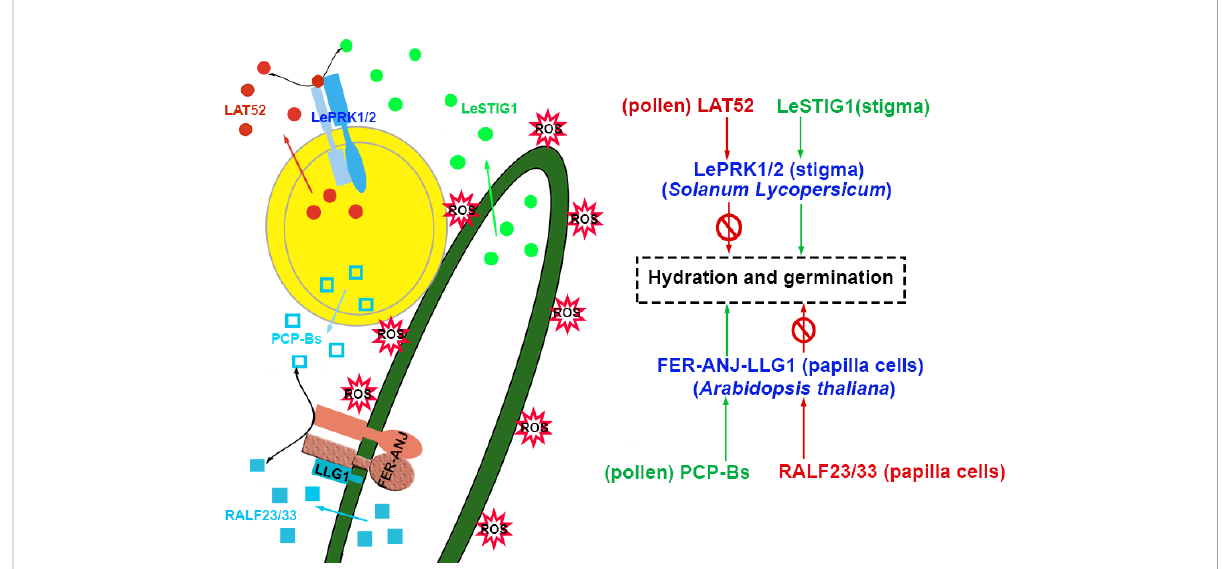
FIGURE 2 Pollen and stigma recognize each other to initiate the hydration and germination of pollen. In Solanum Lycopersicum , LAT52 interacts with LePRK1/2 to inhibit hydration and germination, and LeSTIG1 interacts with LePRK1/2 to facilitate hydration and germination. However, in Arabidopsis , pollen-speci fi c PCP-Bs bind to FER/ANJ-LLG1 to promote hydration and germination, and stigmatic RALF23/33 interacts with FER/ ANJ-LLG1 to maintain ROS accumulation and repress hydration of pollen. The peptides involved in the activation and inhibition of signaling pathways are highlighted in green and red, respectively. The receptor complexes are marked in blue and the co-receptors are shown in parentheses. The source of peptides and receptors is shown in parentheses. Abbreviations for all small peptides and receptors are elucidated in the